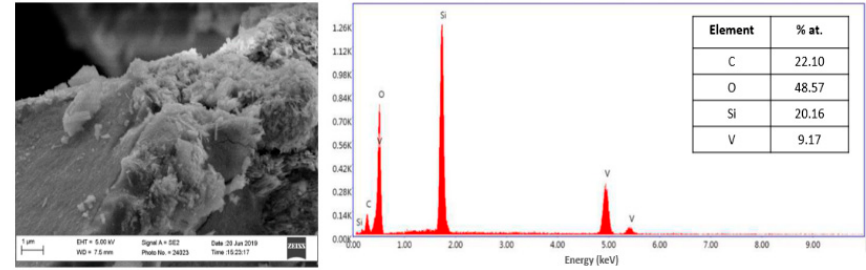
Figure 9. SEM-EDX analysis on V5 1.7 _12h sample functionalized with silica.